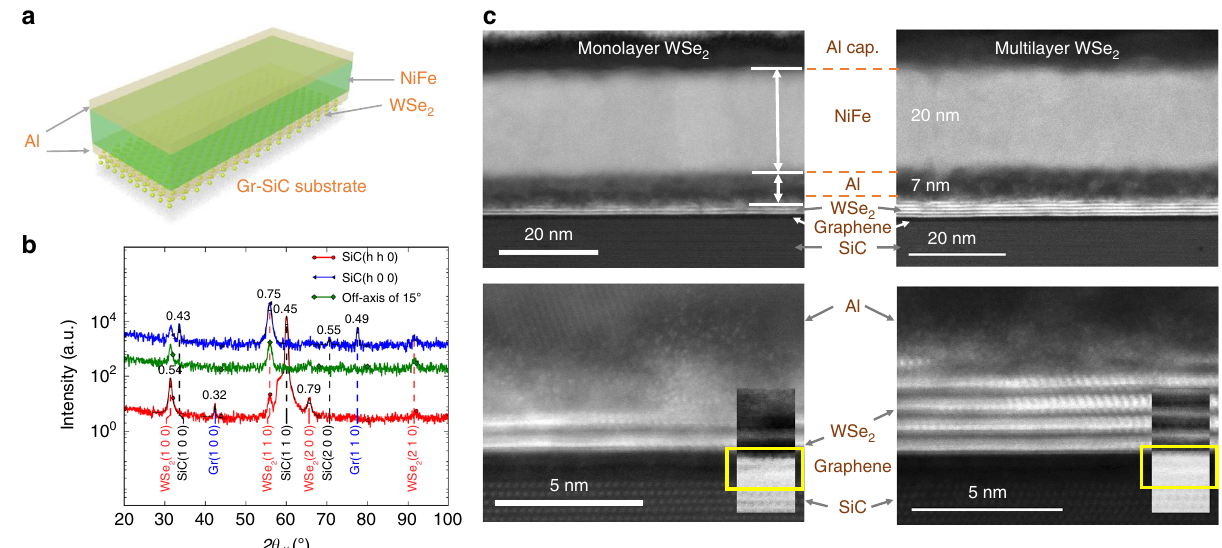
Fig. 1 Characterizations of the WSe 2 layers. a Schematic of the stack grown in-situ and employed for the VNE experiments. b In-plane θ = 2 θ scans along different crystallographic axis with respect to the SiC substrate. Full width at half maximum of re fl ection peaks are indicated. c STEM-HAADF images of the two stacks composed of one monolayer WSe 2 (top left) and multilayer WSe 2 (top right). Abrupt interfaces between WSe 2 and graphene of the stacks can be identi fi ed at atomic scale when increasing the magni fi cation: monolayer WSe 2 (bottom left) and multilayer WSe 2 (bottom right). The insets are bright- fi eld images showing graphene sheets (yellow box).